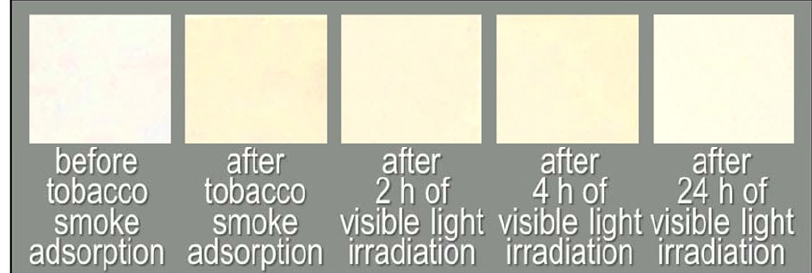
Figure 6. Photographs of the non ‐ woven fabric with Fe/TiO 2 before tobacco smoke adsorption, after tobacco smoke adsorption (0 h) and after 2, 4, and 24 h of visible light irradiation.